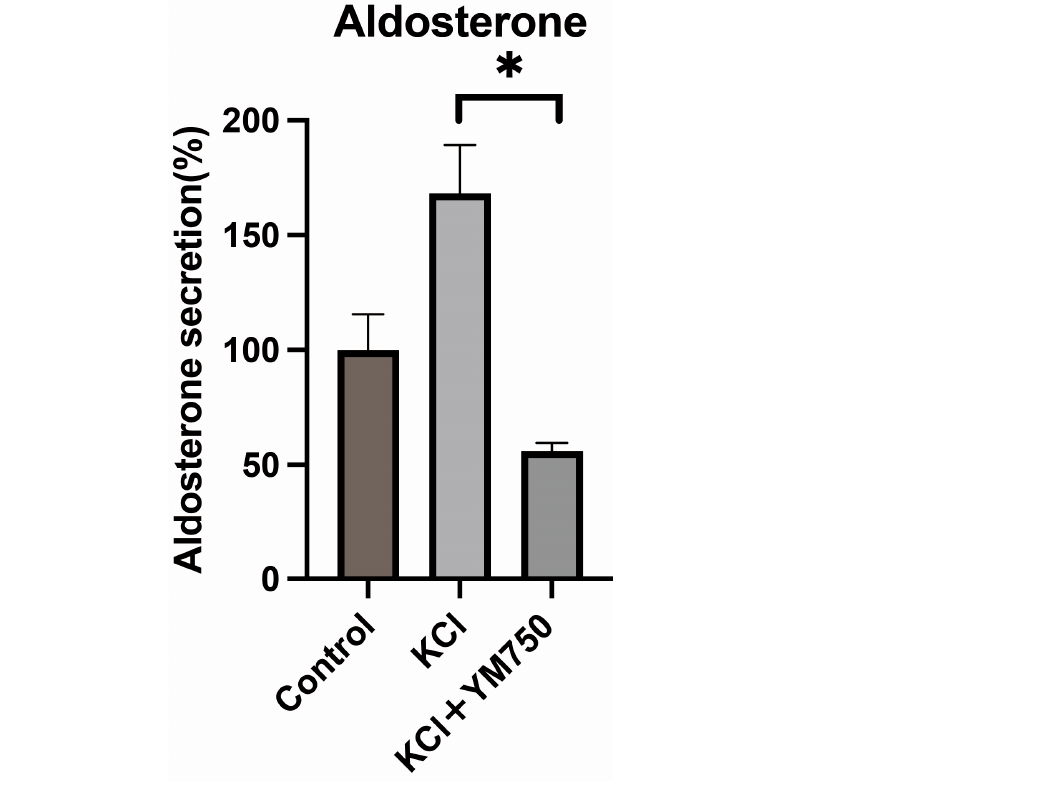
Figure 3. Effect of YM750 (10 mM) on aldosterone secretion by KCl (20 mM) stimulation. * p < 0.05, n = 4.